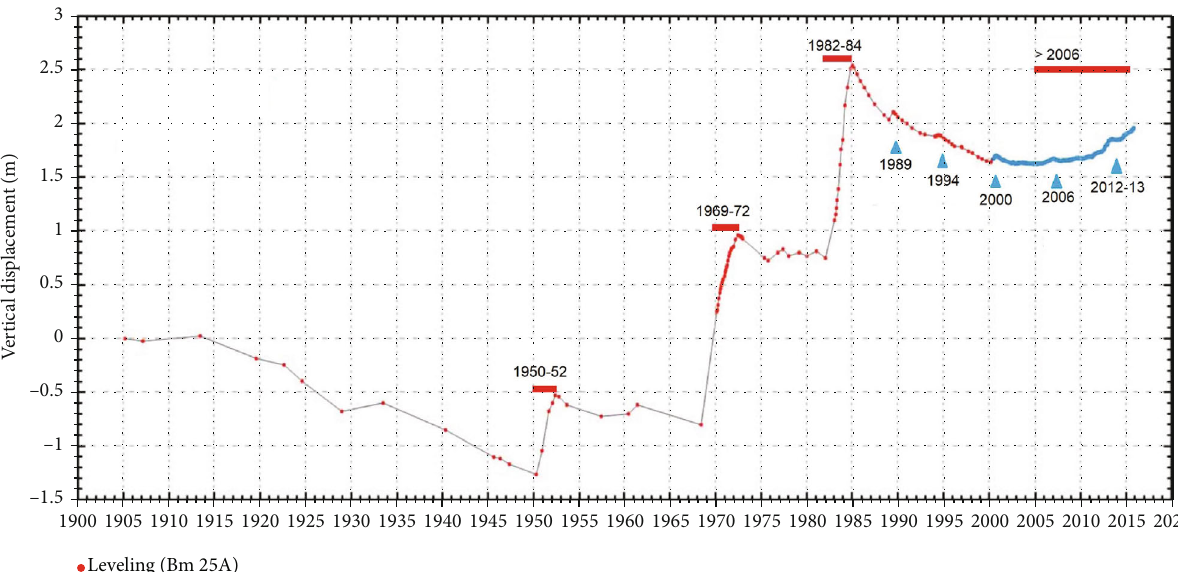
Figure 2: Ground displacement at Pozzuoli Porto since 1905, measured by precision leveling (until year 2000, in red) and at the close GPS benchmark of Rione Terra (since 2000, blue dots) (from Moretti et al.